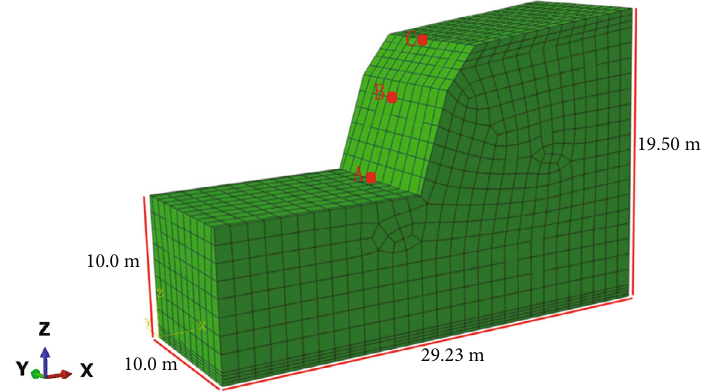
Figure 2: Finite element model of the original slope.